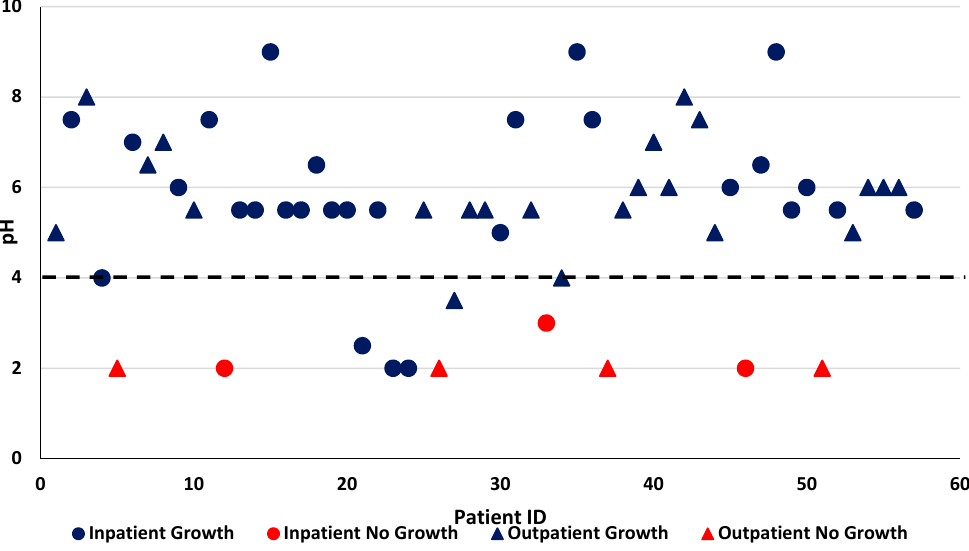
Figure 2. Presence or Absence of Bacterial Growth by pH.